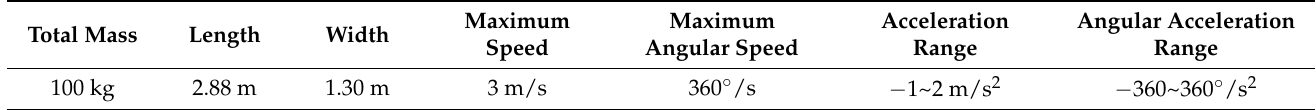
Total Mass Length Width